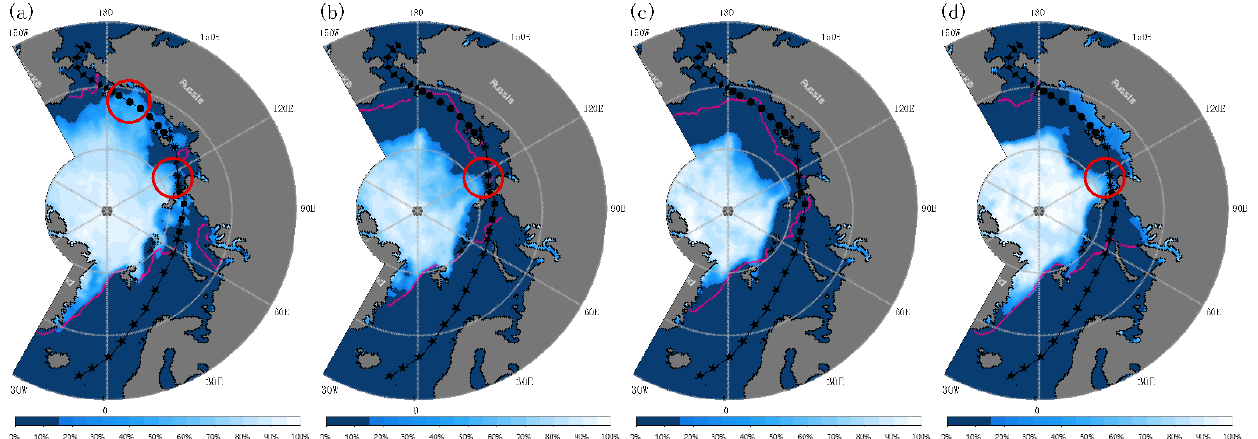
Figure 6. Spatial distribution map of sea ice concentration from July to October 2019 ( a – d ). (The red circles represent the special areas, the red line is the average sea ice edge line for each month from 1981 to 2010.).